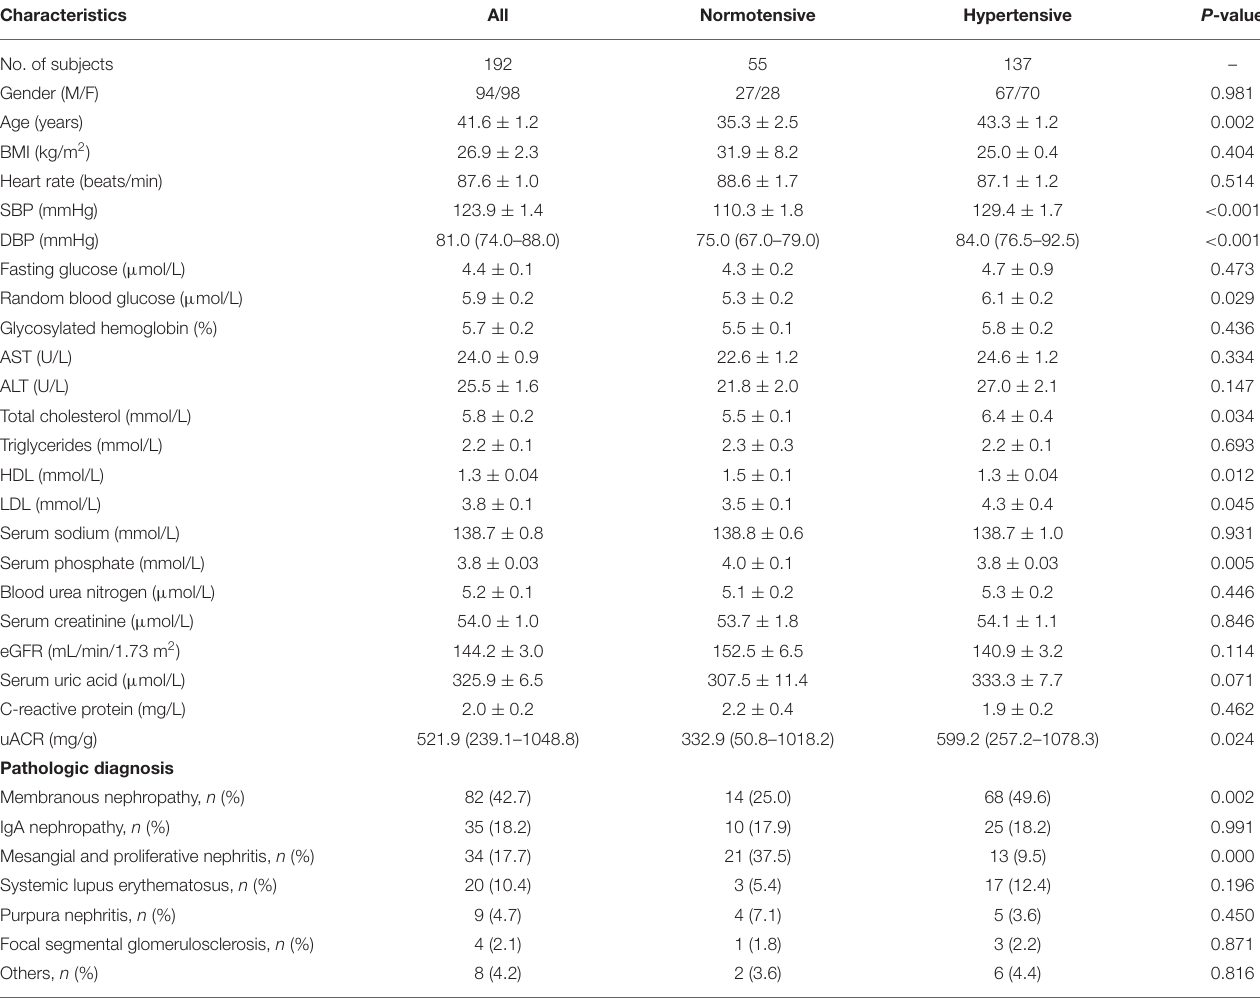
TABLE 6 | Clinical characteristics of patients categorized by BP status in the case-control study ( n = 193).